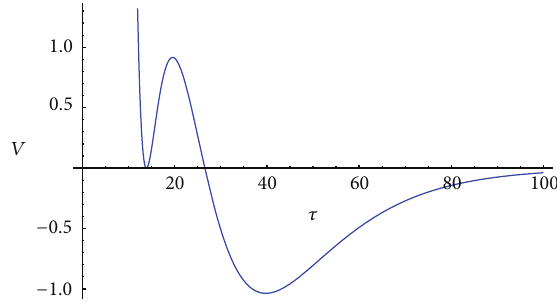
Figure 8: The F-term scalar potential (multiplied by 10 7 ) for KL model possesses both metastable Minkowski vacuum which is supersymmetric and another AdS minimum, for 𝐴 = 𝐵 = 1 , 𝑎 = 0.1 , and 𝑏 = 0.05